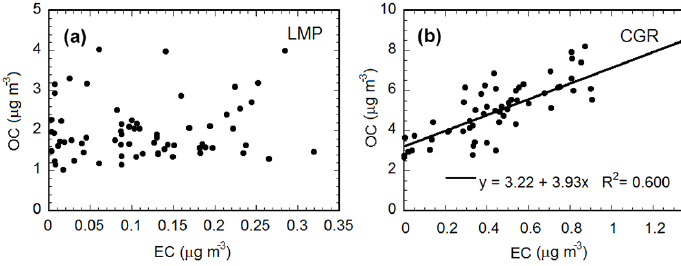
Figure 3. Scatter plot of OC vs. EC at LMP (a) and CGR (b) . Note the different vertical